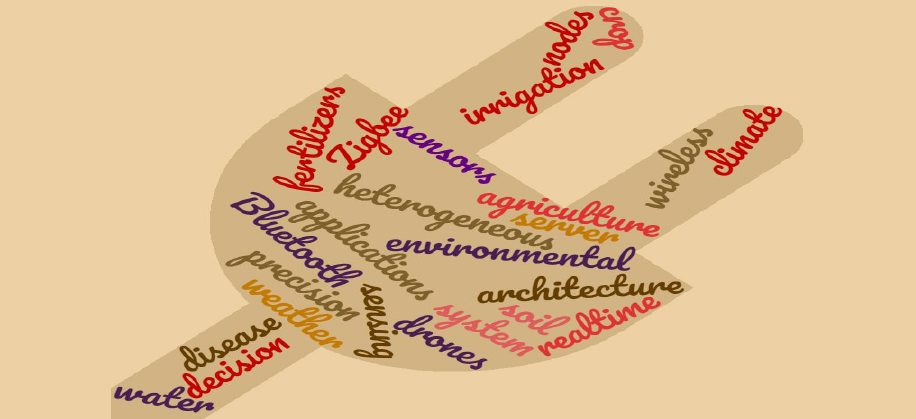
Figure 17. Word cloud for “Deep learning for IoT big data and streaming analytics: A